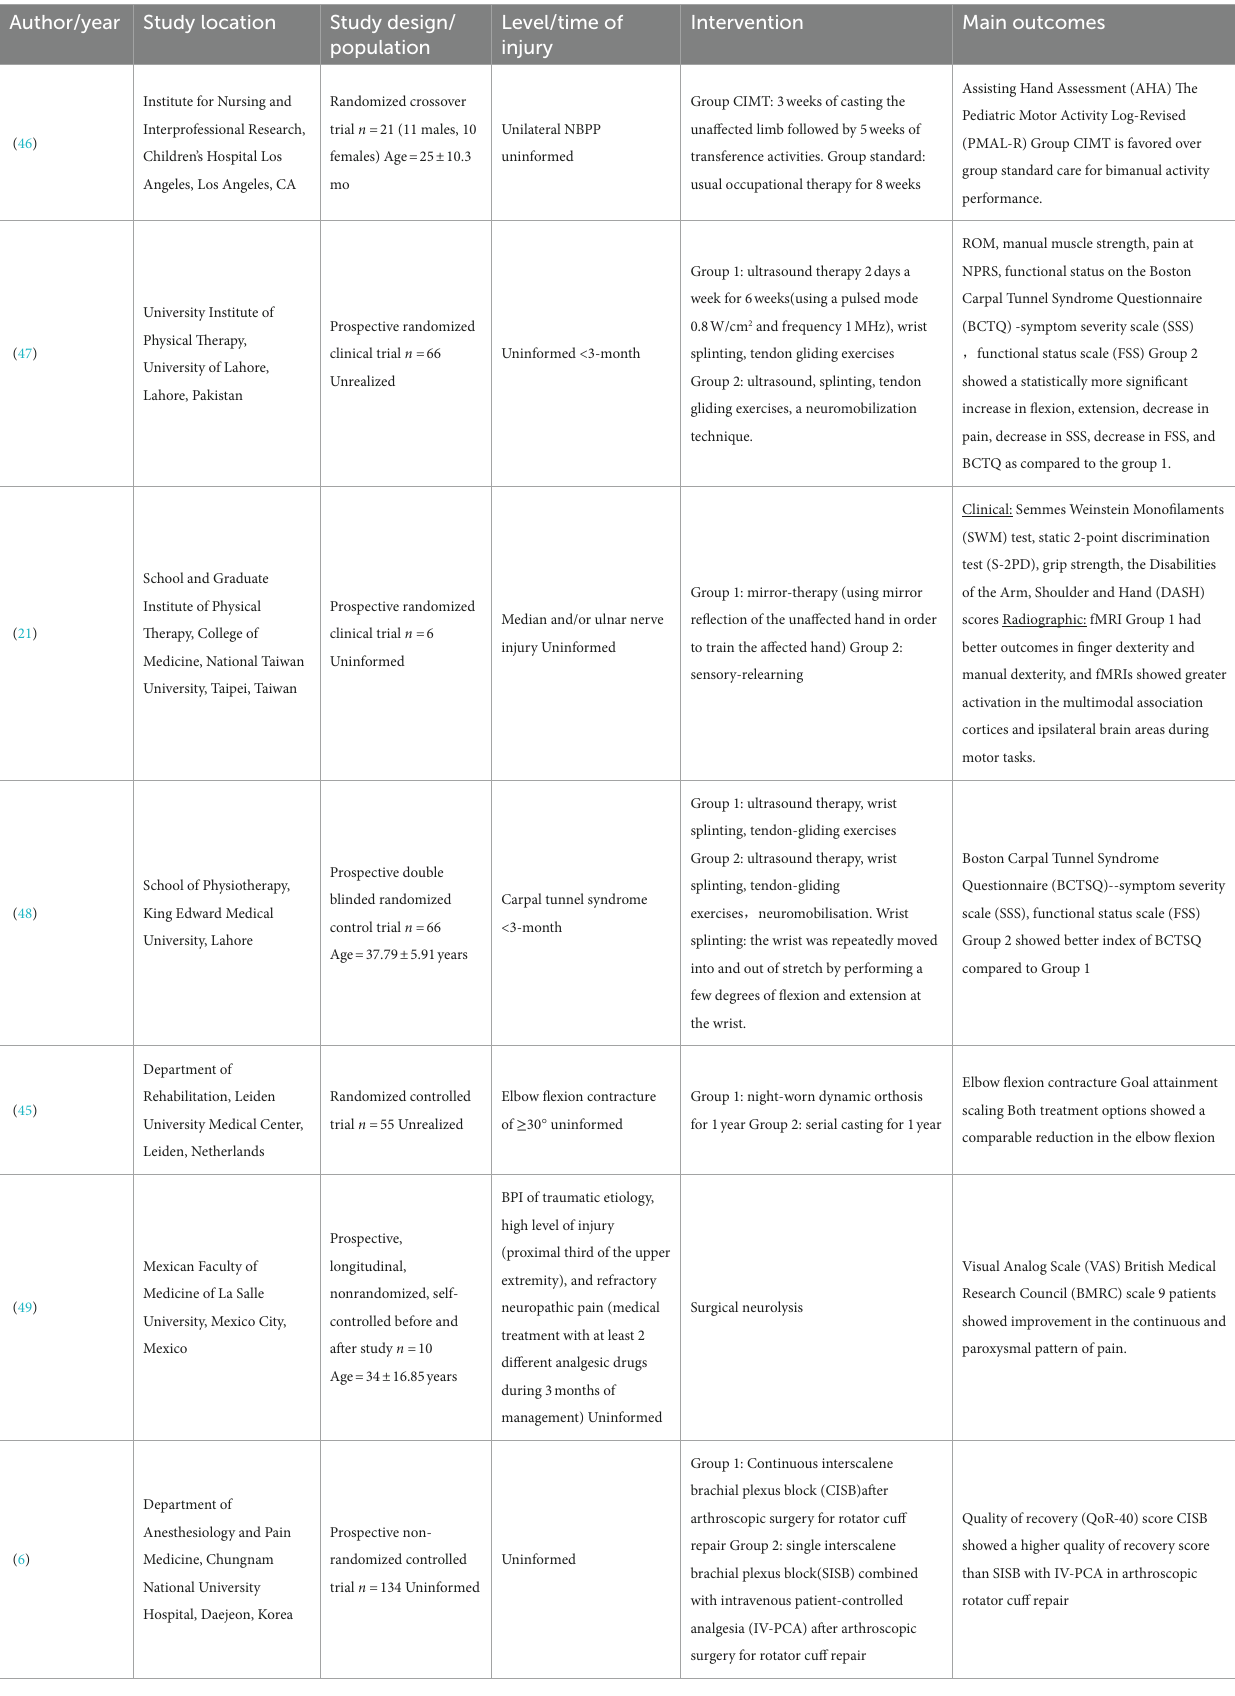
TABLE 1 Characteristics of the clinical studies on rehabilitation of brachial plexus injuries published in recent